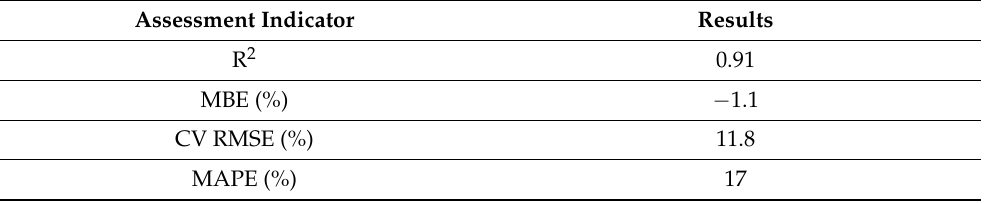
Table 4. Model quality characteristics. Assessment